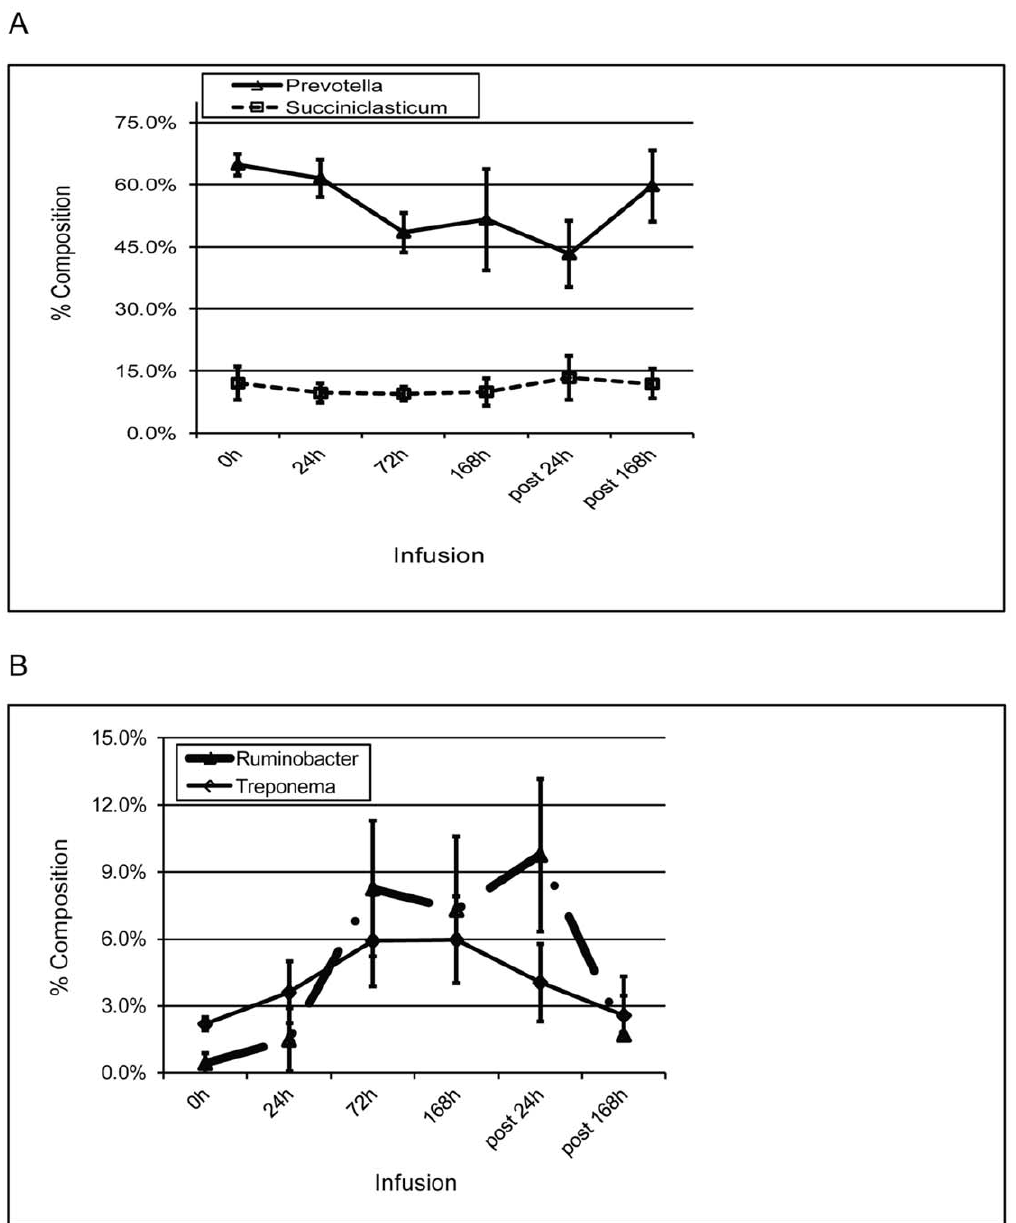
Figure 3. Temporal changes in the relative abundance (% reads) of A) 2 most dominated genera, Prevotella (solid line) and Succininclasticum (dashed line), and B) Ruminobacter and Treponema , in the rumen microbial community of dairy cows in response to butyrate infusion. Error bars represent SD of 4 samples. Normalized percentages represent the number of 16S rRNA gene sequences assigned to a given